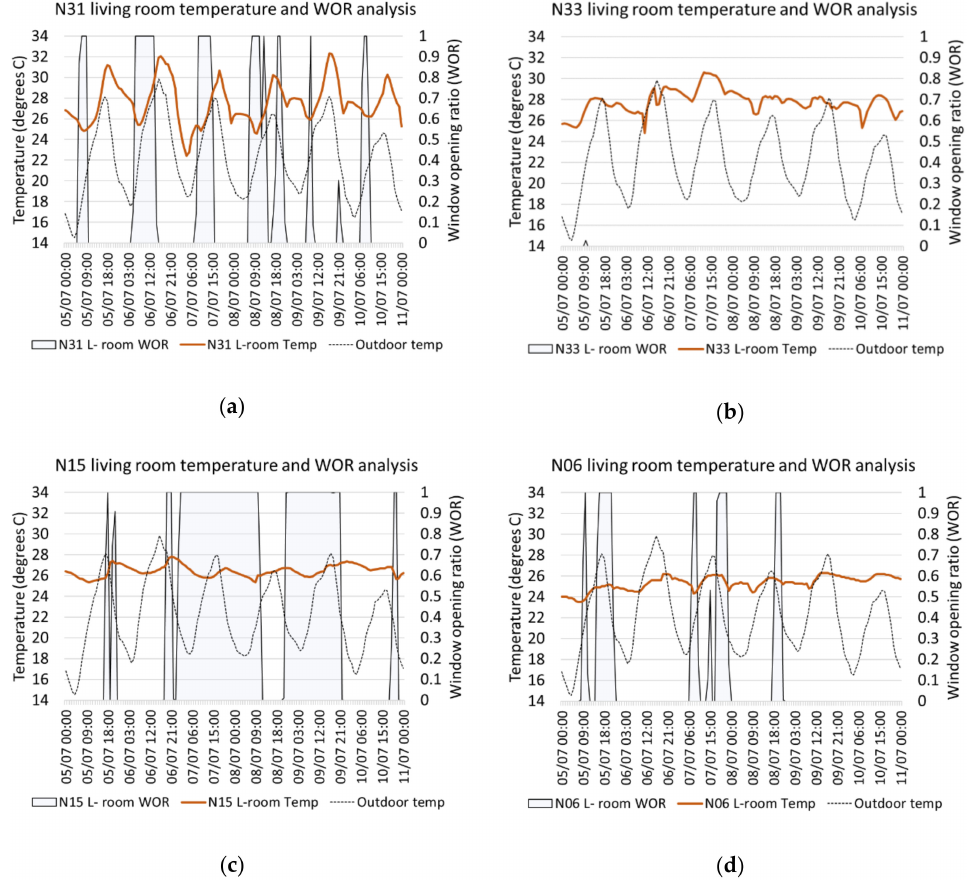
Figure 12. Living room temperature in the case study flats and window opening ratio: ( a ) Flat N31; ( b ) Flat N33; ( c ) Flat N15; ( d ) Flat